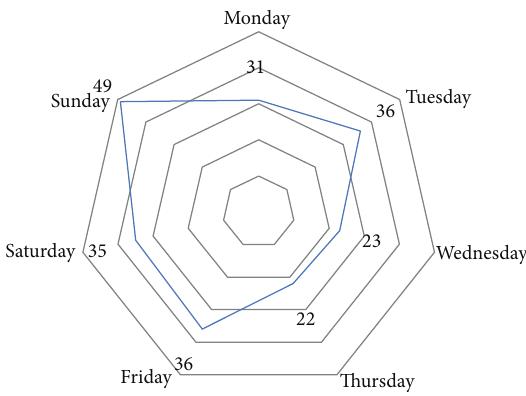
Figure 1: Distribution of accidents according to the day of the week in Campina Grande,